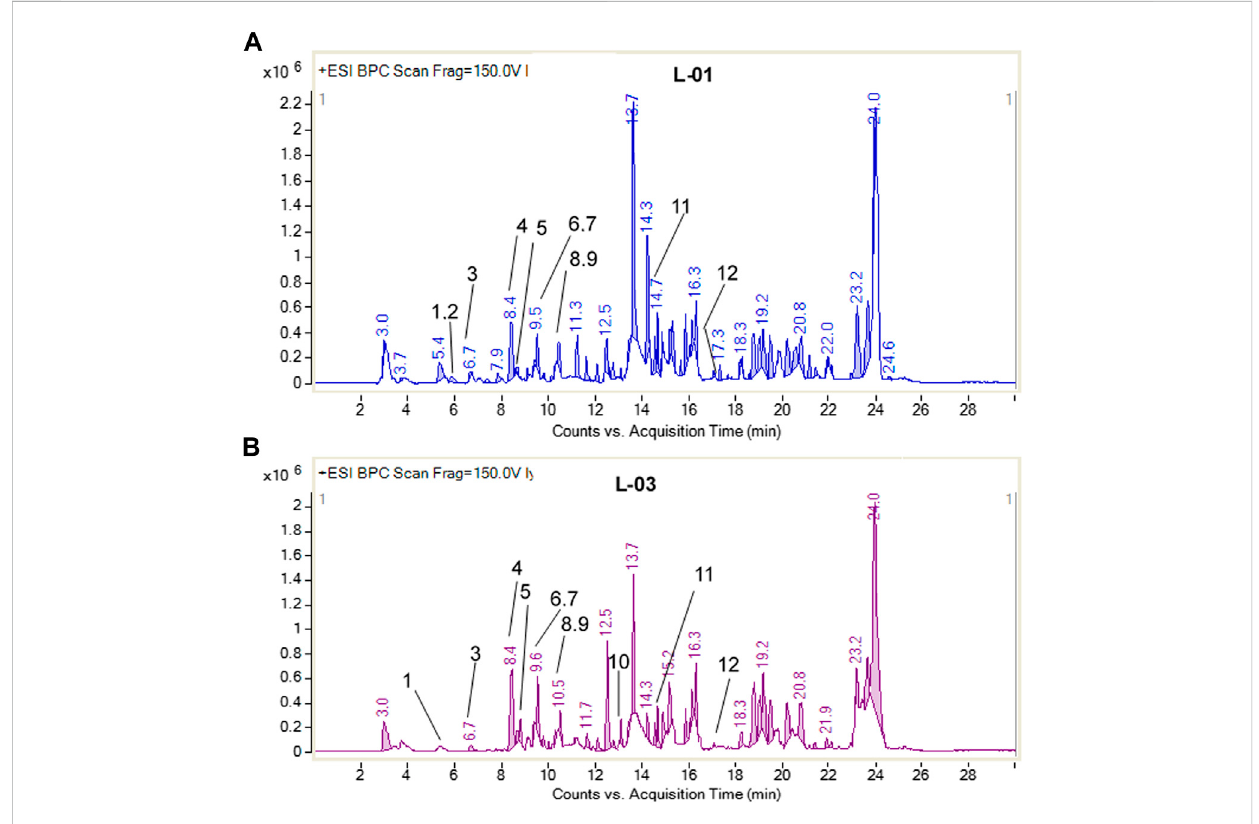
FIGURE 9 Base peak chromatogram of (A) L-01 and (B) L-03, showing 12 compounds